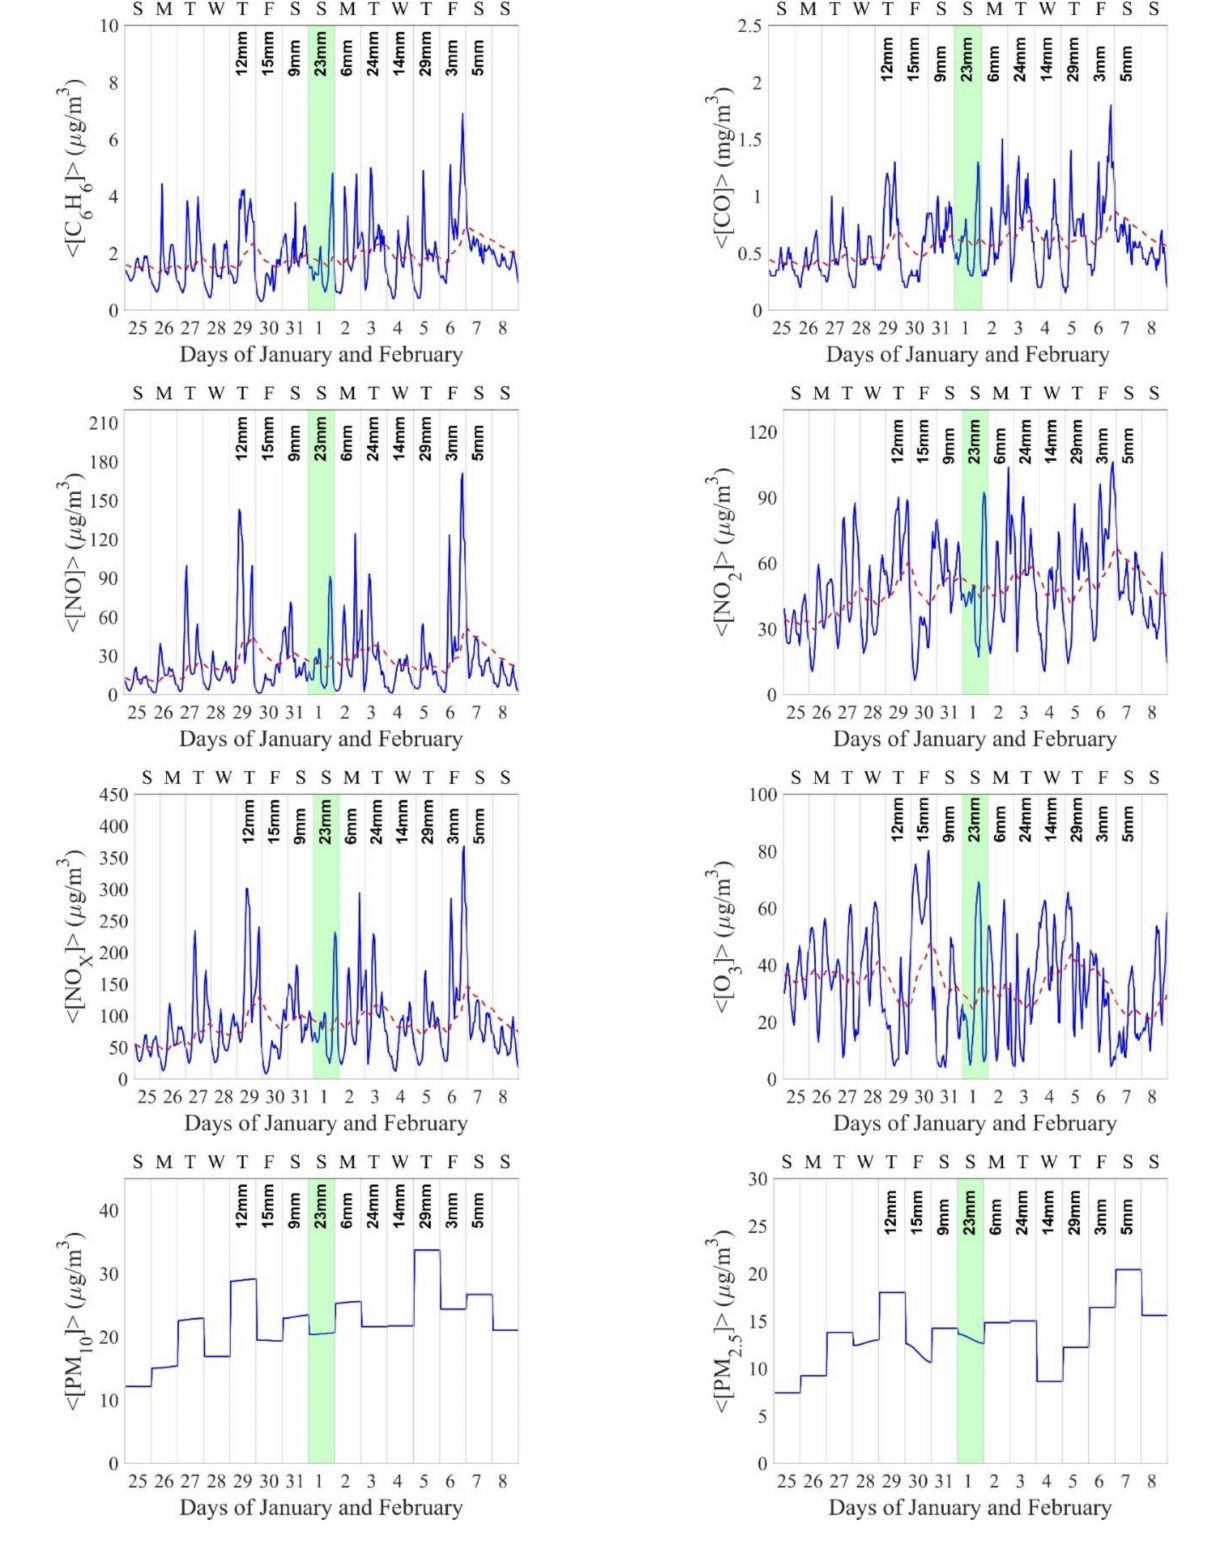
Figure 6. Pollutant concentration variation related to the total block of urban traffic of 1st February 2015 (green band). The blue line is the hourly pollutant concentration. The Red dashed line is the daily mean pollutant concentration. Data of daily precipitation are